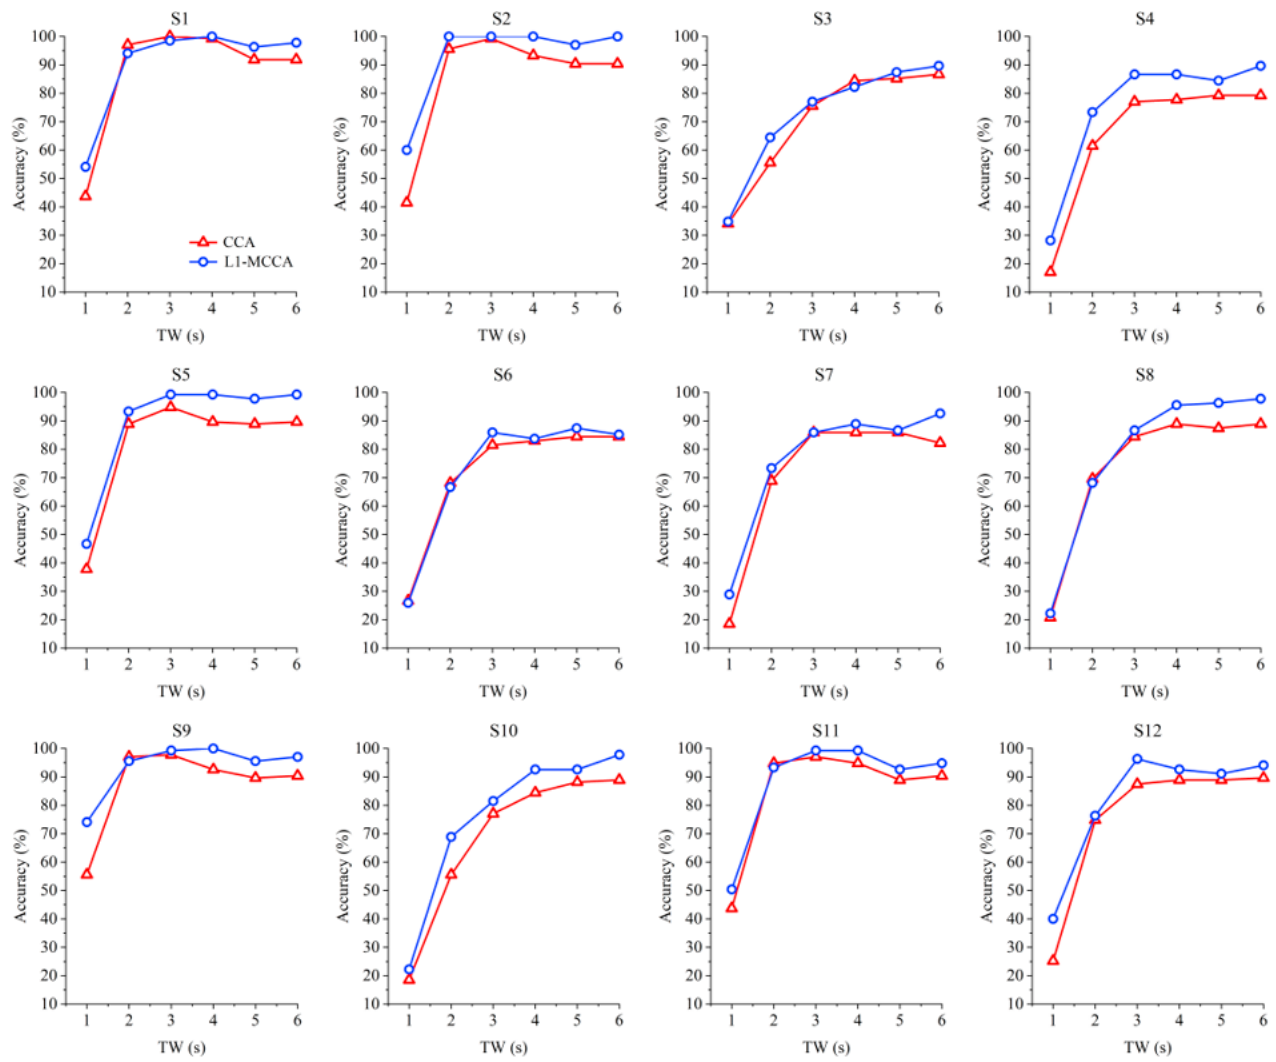
Figure 3. The SSVEP recognition accuracy rates of the 12 subjects derived by the CCA and L1-MCCA, respectively, with different time window (TW) from 1 to 6